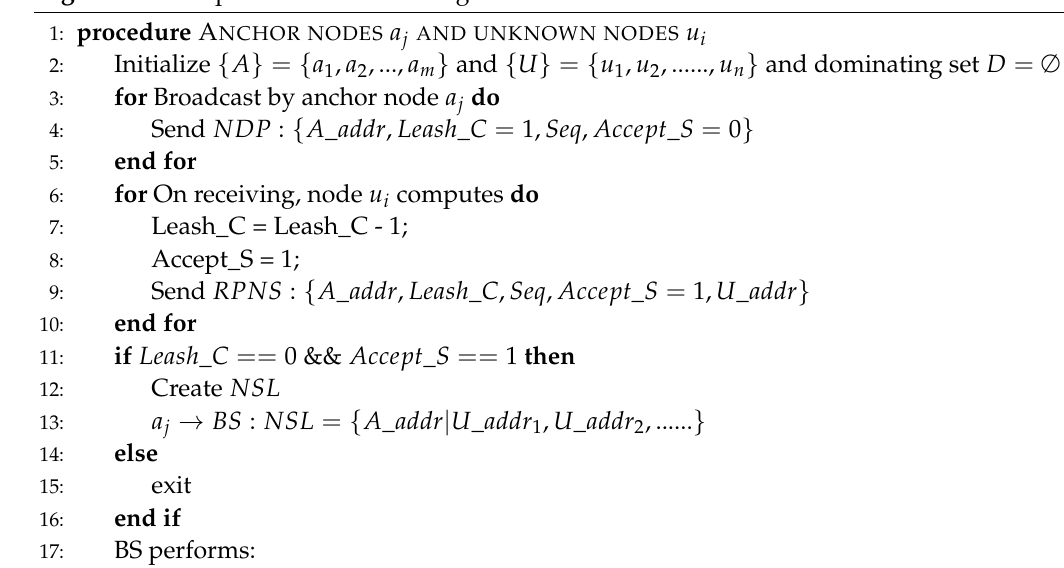
Algorithm 1 Proposed Localization